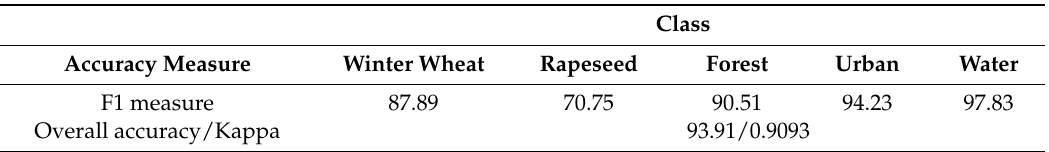
Table 5. Accuracy of winter wheat using the four SAR datasets (22 November 2015, 9 January 2016,